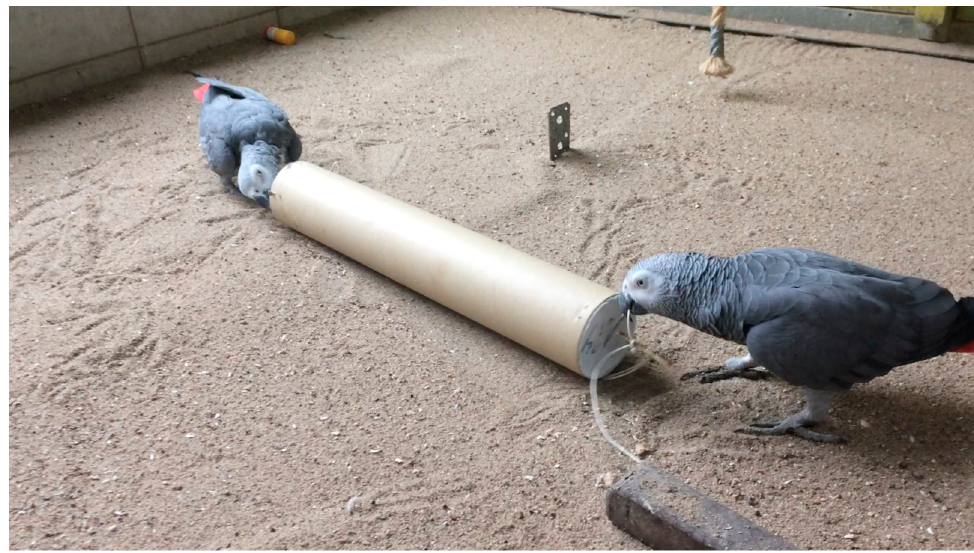
Figure 8. metamusic , tube device [8].